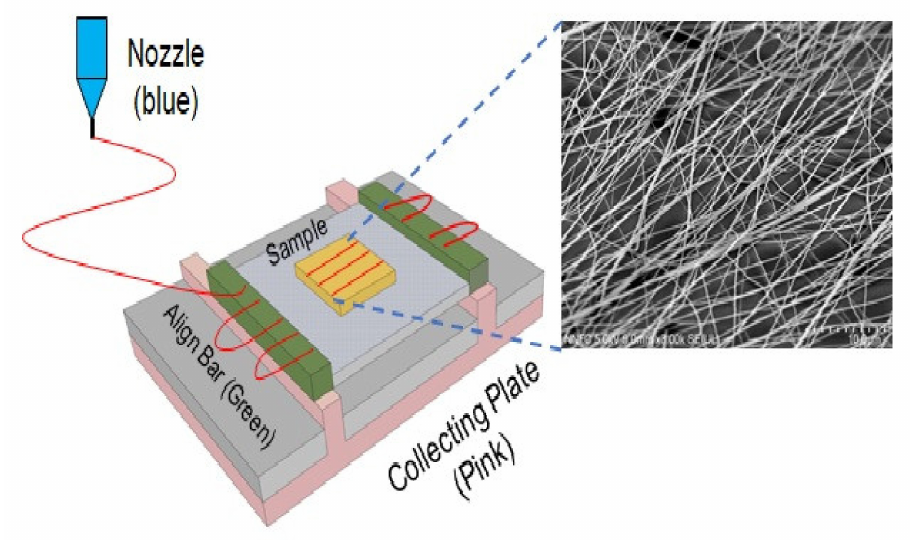
Figure 2. Diagram of the electrospinning system for parallel alignment of electrospun fibers.